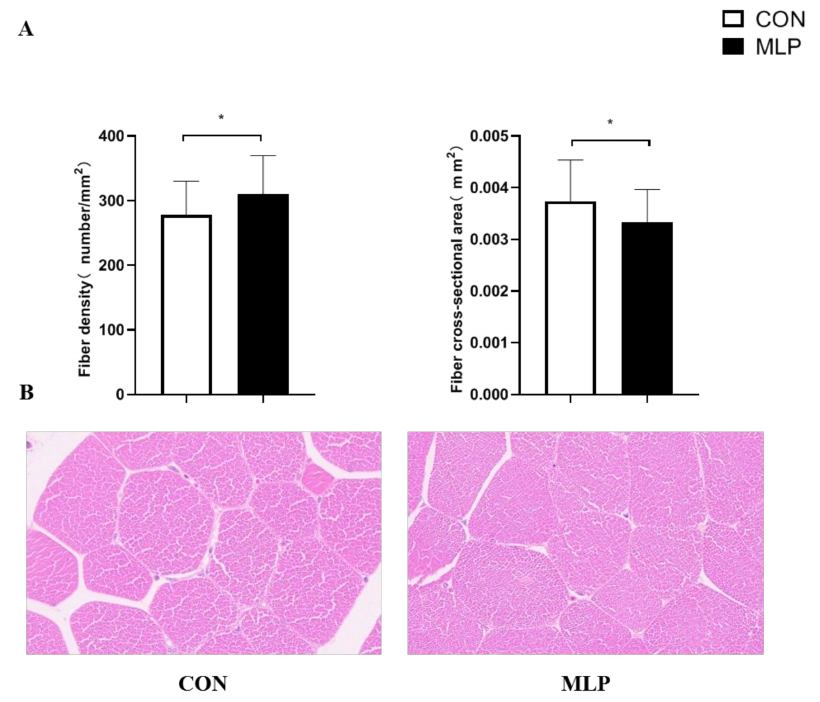
Figure 2. Effect of dietary supplementation with mulberry leaf powder (MLP) on histological characteristics of longissimus thoracis (LT) muscle in Tibetan pigs. ( A ) H&E staining determined